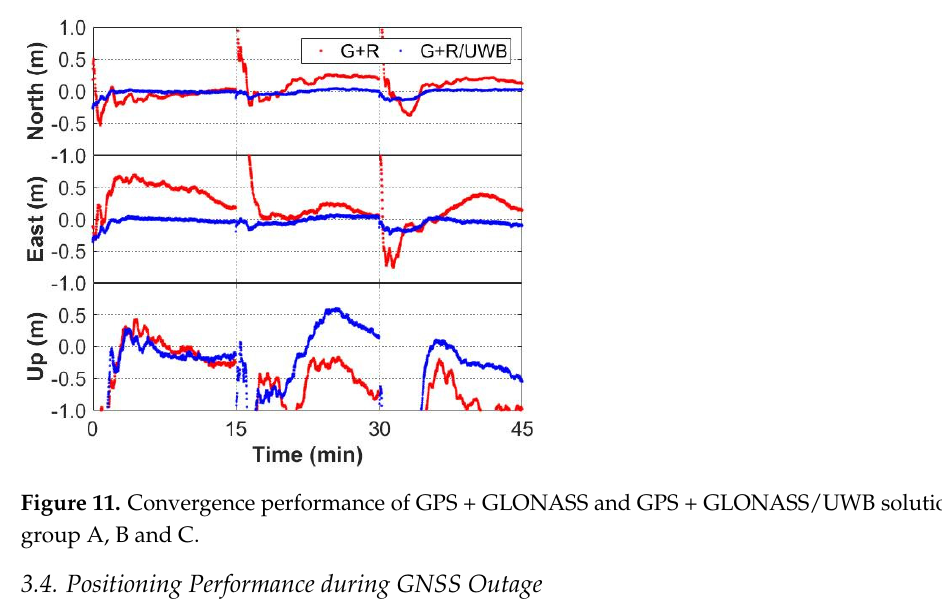
Figure 10. Convergence performance of GPS-only and GPS/UWB solutions for group A, B and C.